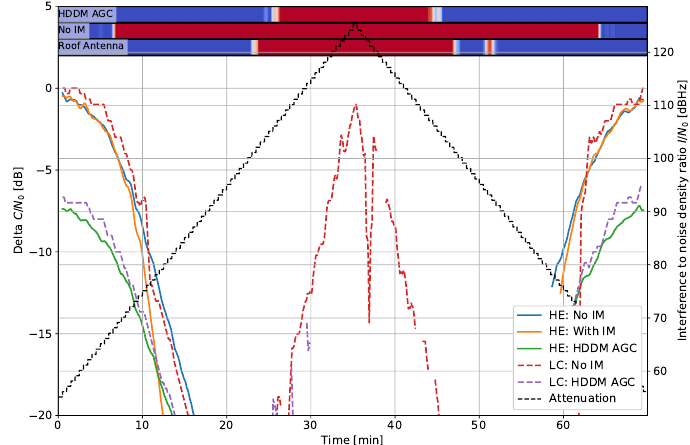
Figure 9. Interference #6: Delta C / N 0 for filtered noise with 4 MHz bandwidth.